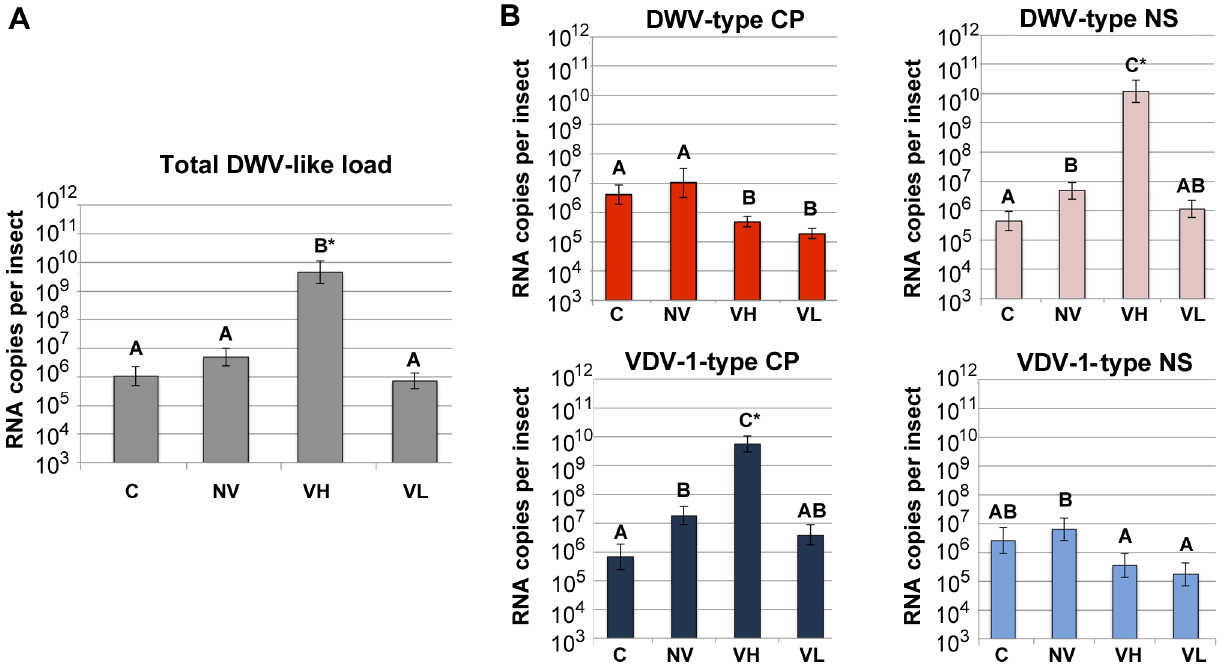
Figure 4. Total and strain-specific virus genome quantification in honeybee pupae. Quantification of the viral RNA by qRT-PCR in the honeybee pupae from the frame transfer experiment. Numbers of the viral RNA molecules per pupa ( n =8 for each experimental group) are shown. (A) Total DWV-like virus load quantified with the primers recognising the NS region of all DWV-like viruses (DWV, VDV-1, recombinants thereof and KV). (B) Quantification of the DWV CP, DWV NS, VDV-1 CP, and VDV-1 NS with the specific primers. Bars show mean value with standard error (SE). Letters above the bars represent statistically significant groupings according to pairwise t -test comparisons, p , 0.05; asterisk marks p , 0.0001.